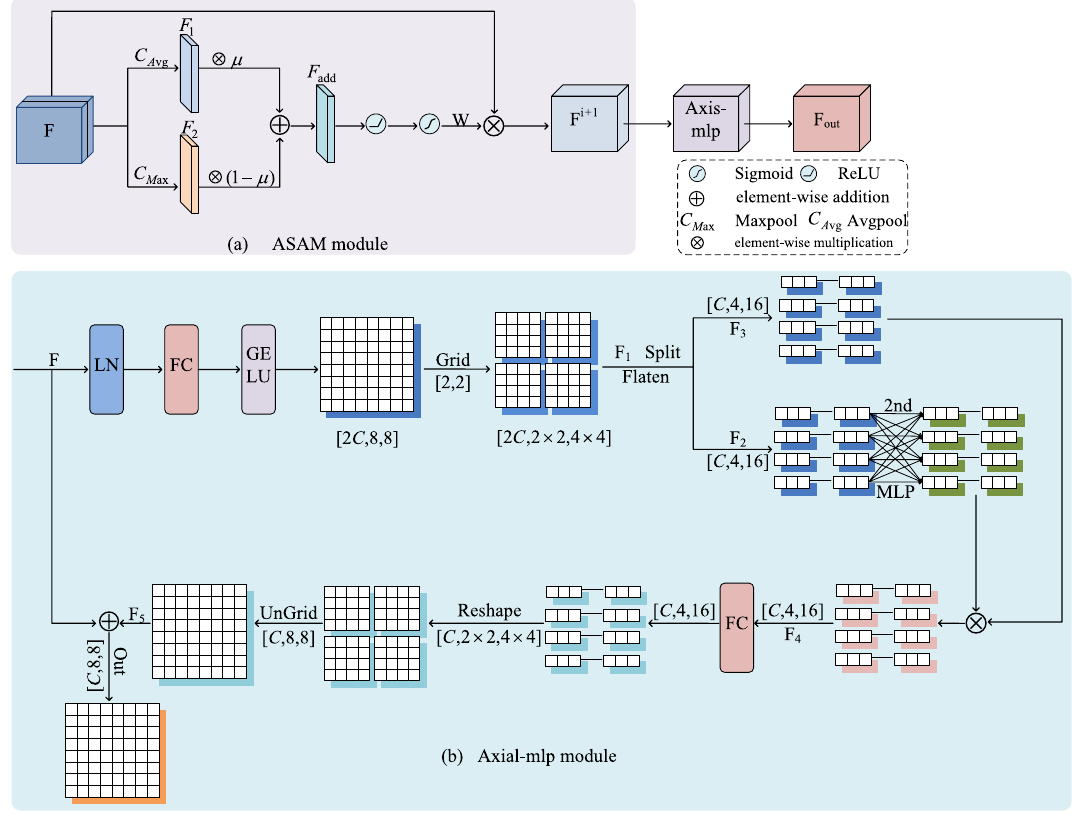
Figure 3. Overall architecture of DSLA module (created by ‘Microsoft Office Visio 2013’ URL: https:// www. micro soft. com/ zh- cn/ micro soft- 365/ previ ous- versi ons/ micro soft- vision-